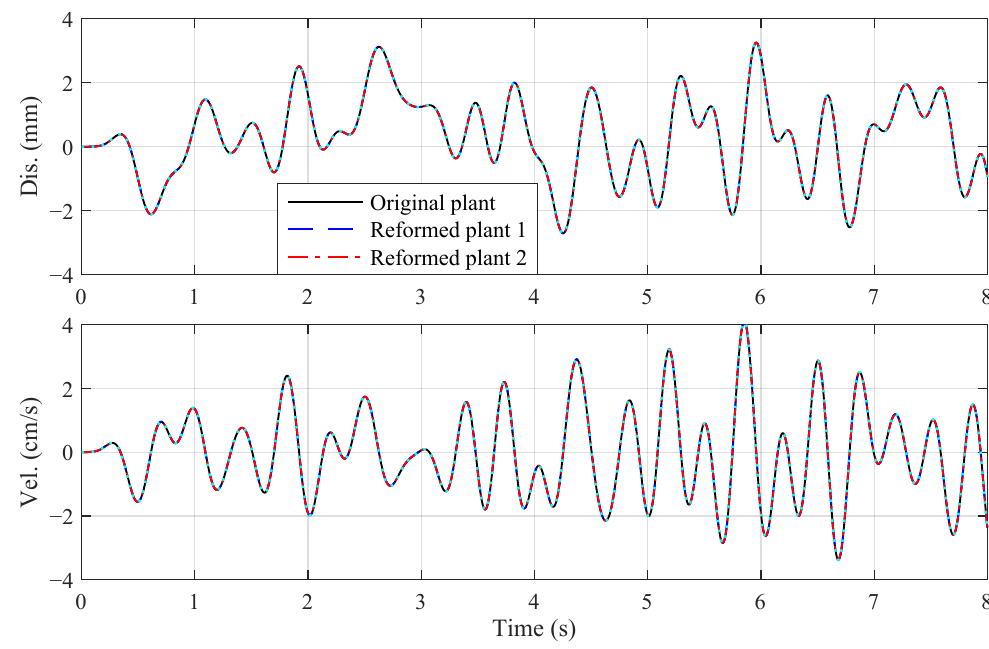
Figure 1. Tracking results for the forced Van der Pol oscillator.